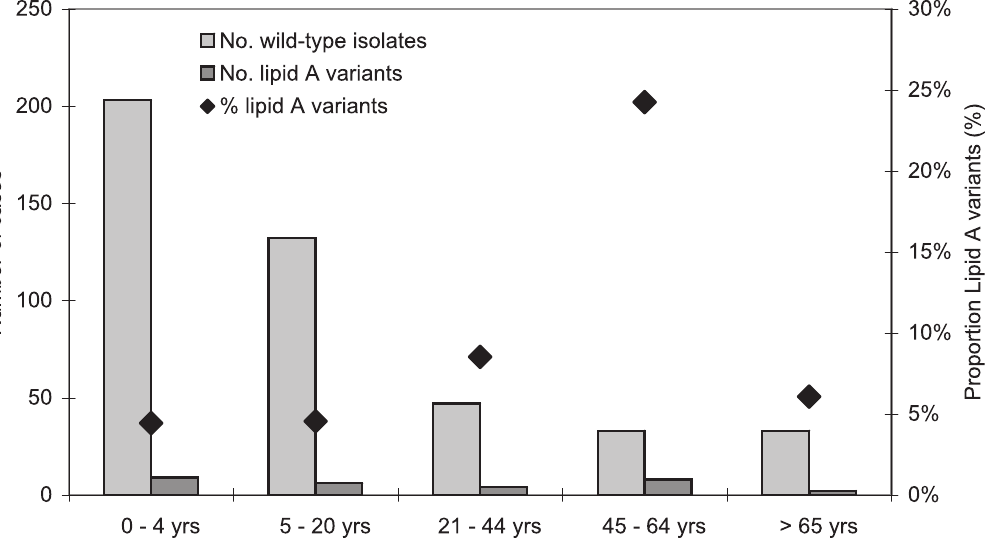
Figure 1. Number of wild-type or lipid A variant disease cases in different age-categories (bars) and proportion of lipid A strains (dots).